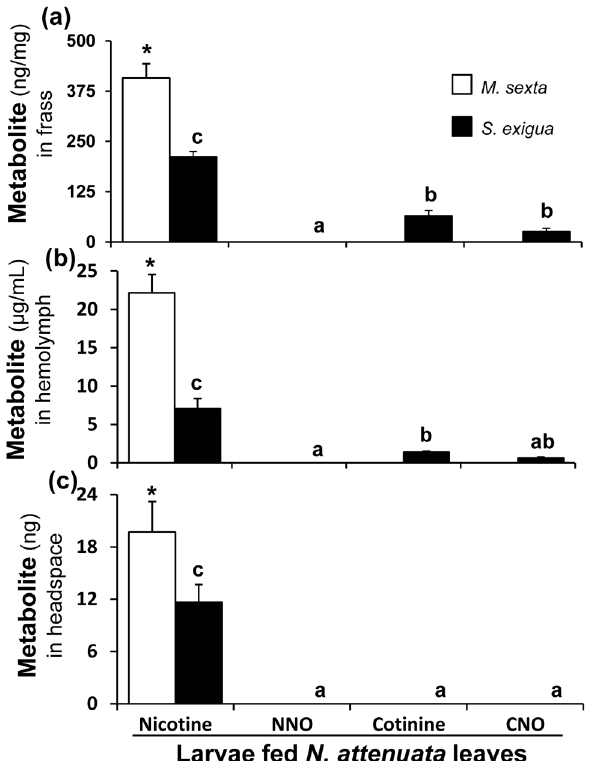
Figure 4. S. exigua oxidizes nicotine, but M. sexta does not. U(H)PLC/ESI-QTOF-MS-based quantitative analysis of nicotine, NNO, cotinine and CNO in ( a ) frass ( b ) hemolymph and ( c ) headspace of third-instar M. sexta (n=5) and S. exigua (n=5) larvae fed N. attenuata leaves. Lower-case letters above the S. exigua bars indicate significant differences ( P # 0.05) among them by one-way ANOVA. Asterisks above the M. sexta nicotine bars indicate that they are significantly different ( P # 0.05) from the S. exigua nicotine bars, as determined by one-way ANOVA. Nicotine oxides were not detected in M. sexta . The detection limit of nicotine was 0.25 ng and 0.5 ng for cotinine, CNO and NNO; efficiency of extraction was . 90% for all these compounds [1].